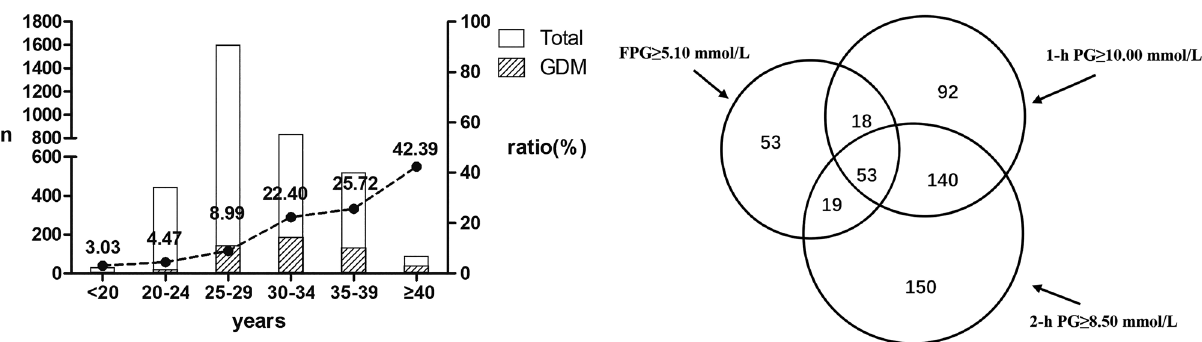
Figure 4: Venn diagram showing detailed breakup of patients diagnosed as gestational diabetes mellitus (GDM) by oral glucose tolerance test (OGTT), according to the International Association of Diabetes and Pregnancy Study Groups (IADPSG) criteria. Five hundred and twenty five GDM pregnant women were break up according to the three cut points plasma glucose levels after OGTT diagnosed by the IADPSG